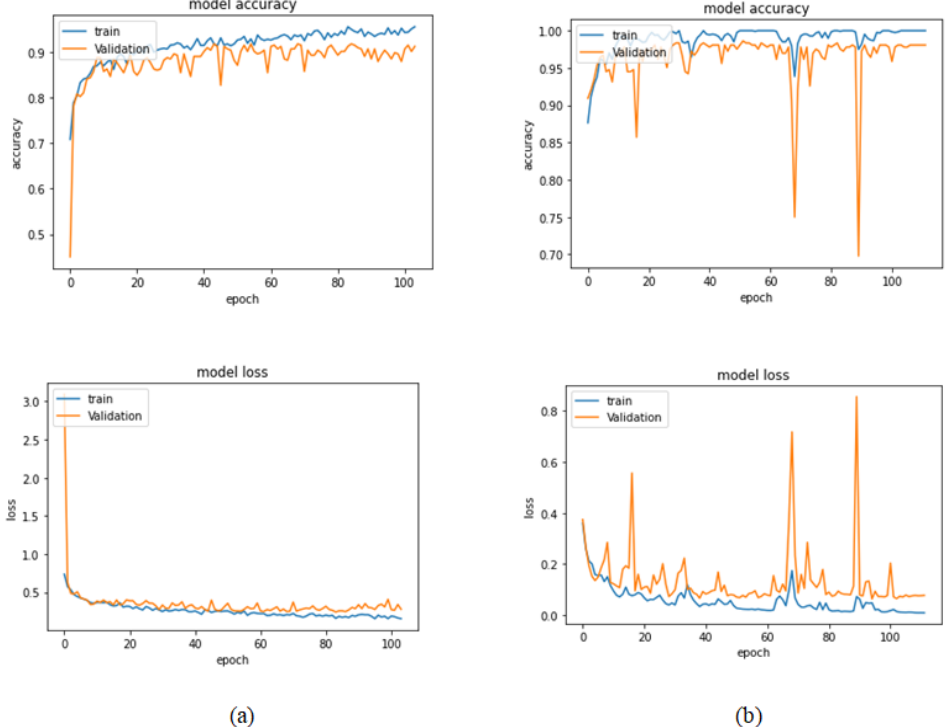
Figure 19. Learning curves for Xception at 0.0001 learning rate in 400× magnification-dependent binary classification. ( a ) Accuracy and loss curves of Phase 1 of training. ( b ) Accuracy and loss curves of Phase 2 of training.